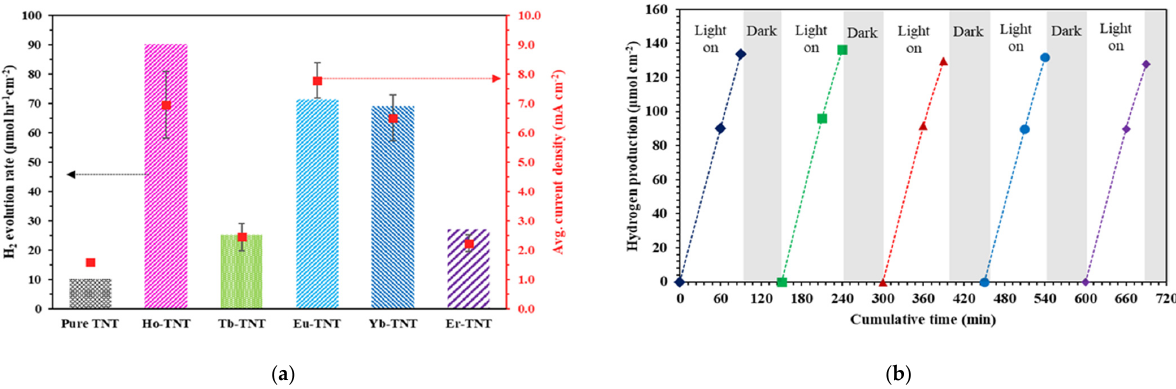
Figure 8. ( a ) Hydrogen evolution rate and average current density; ( b ) five repeated experiments with Ho ‐